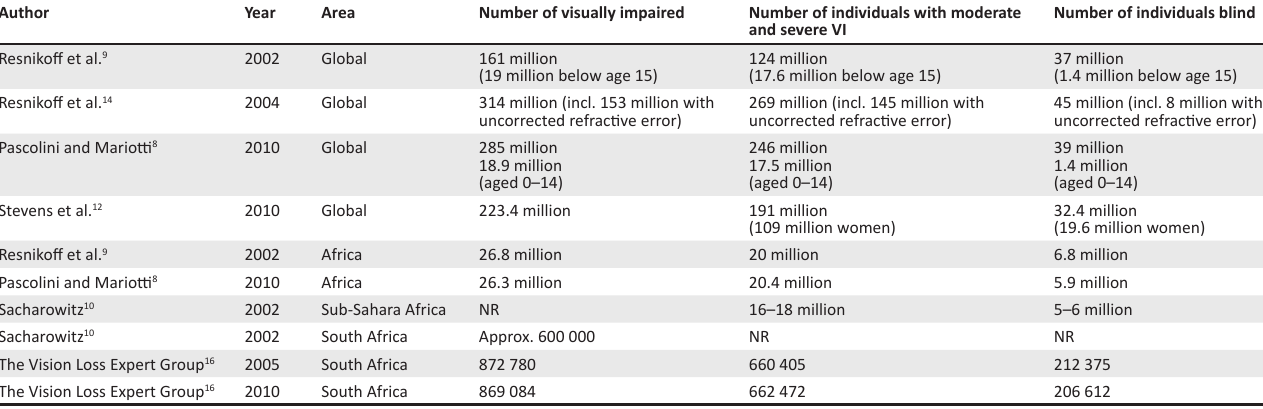
TABLE 2: Summary of studies reporting on the overall prevalence of visual impairment and its different levels. Author